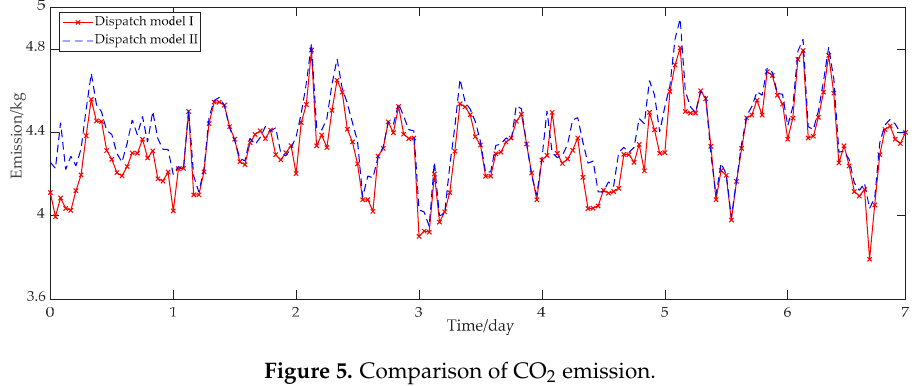
Figure 5. Comparison of CO 2 emission.